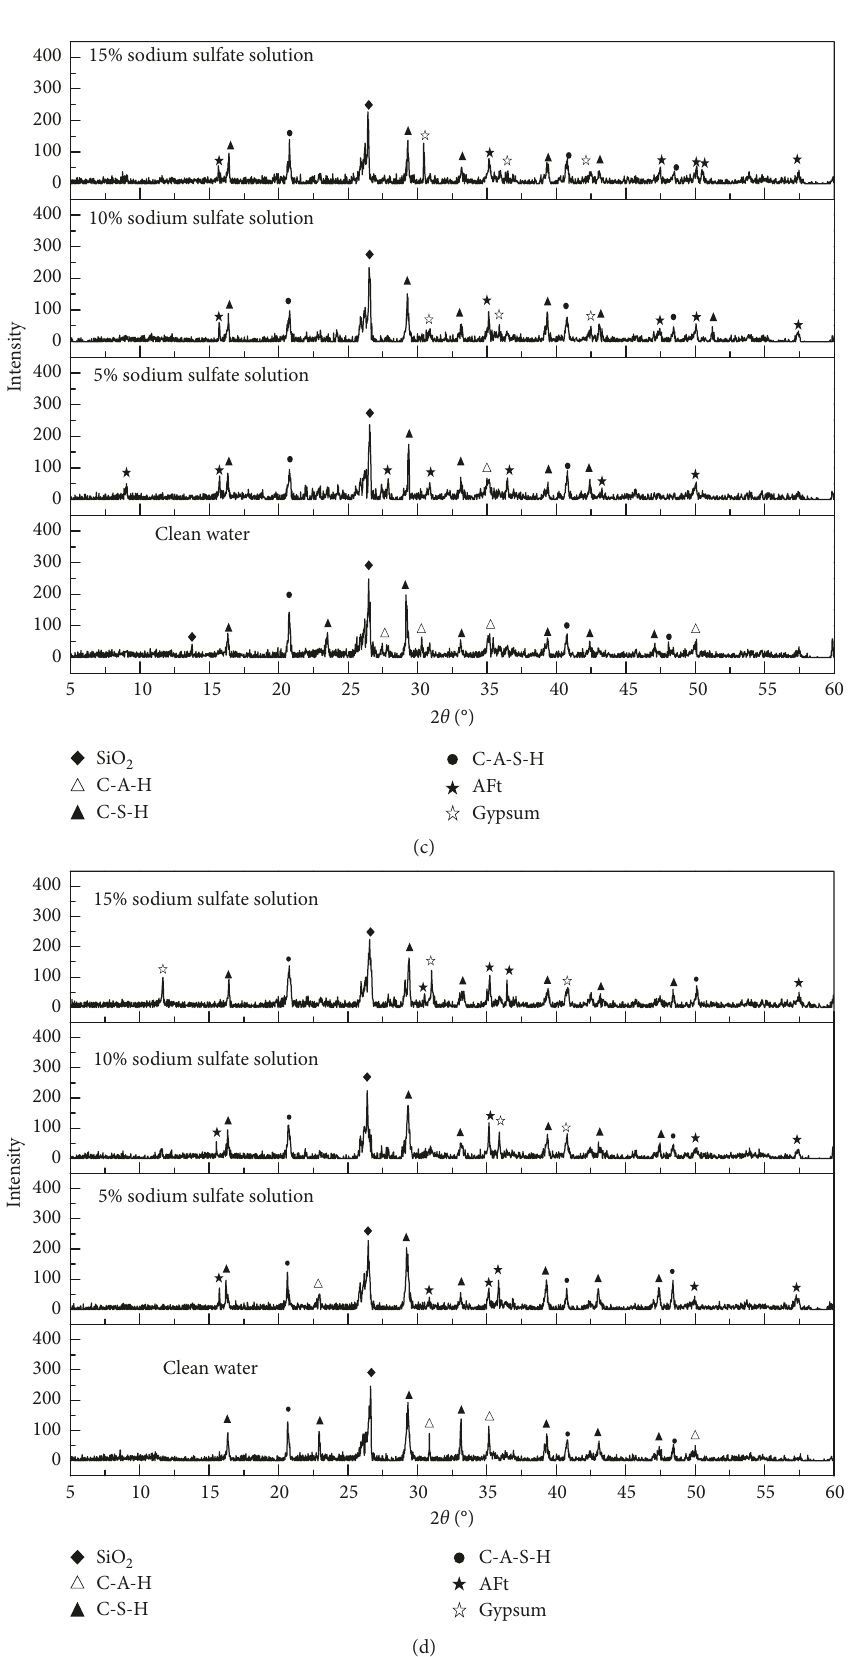
Figure 7: XRD patterns of hydrated products of filling paste in each immersion solution for each soaking period: (a) 30d; (b) 60d; (c) 90d; (d)